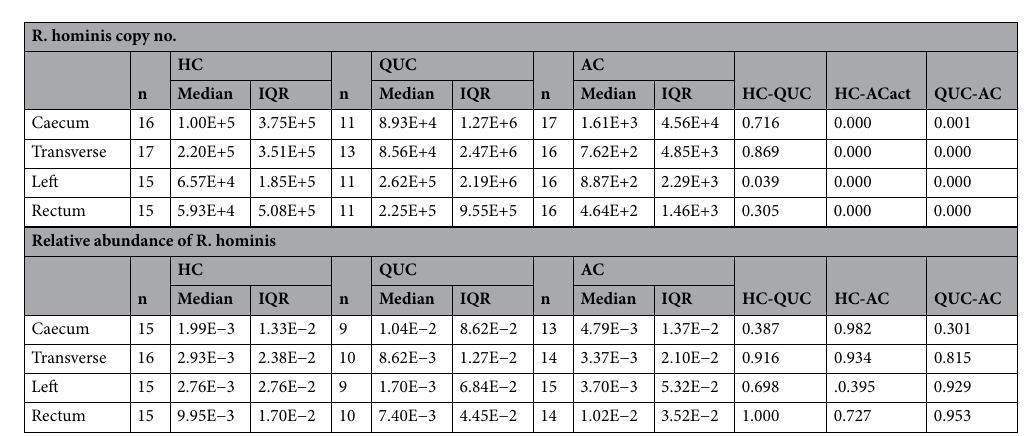
Figure 2. Boxplots representing inter-cohort comparisons of R. hominis . Healthy controls are represented in green, patents with quiescent UC in orange and patients with acute UC in red. * denotes p < 0.05. Loco regional comparison along the longitudinal axis of the colon in the three patient cohorts.